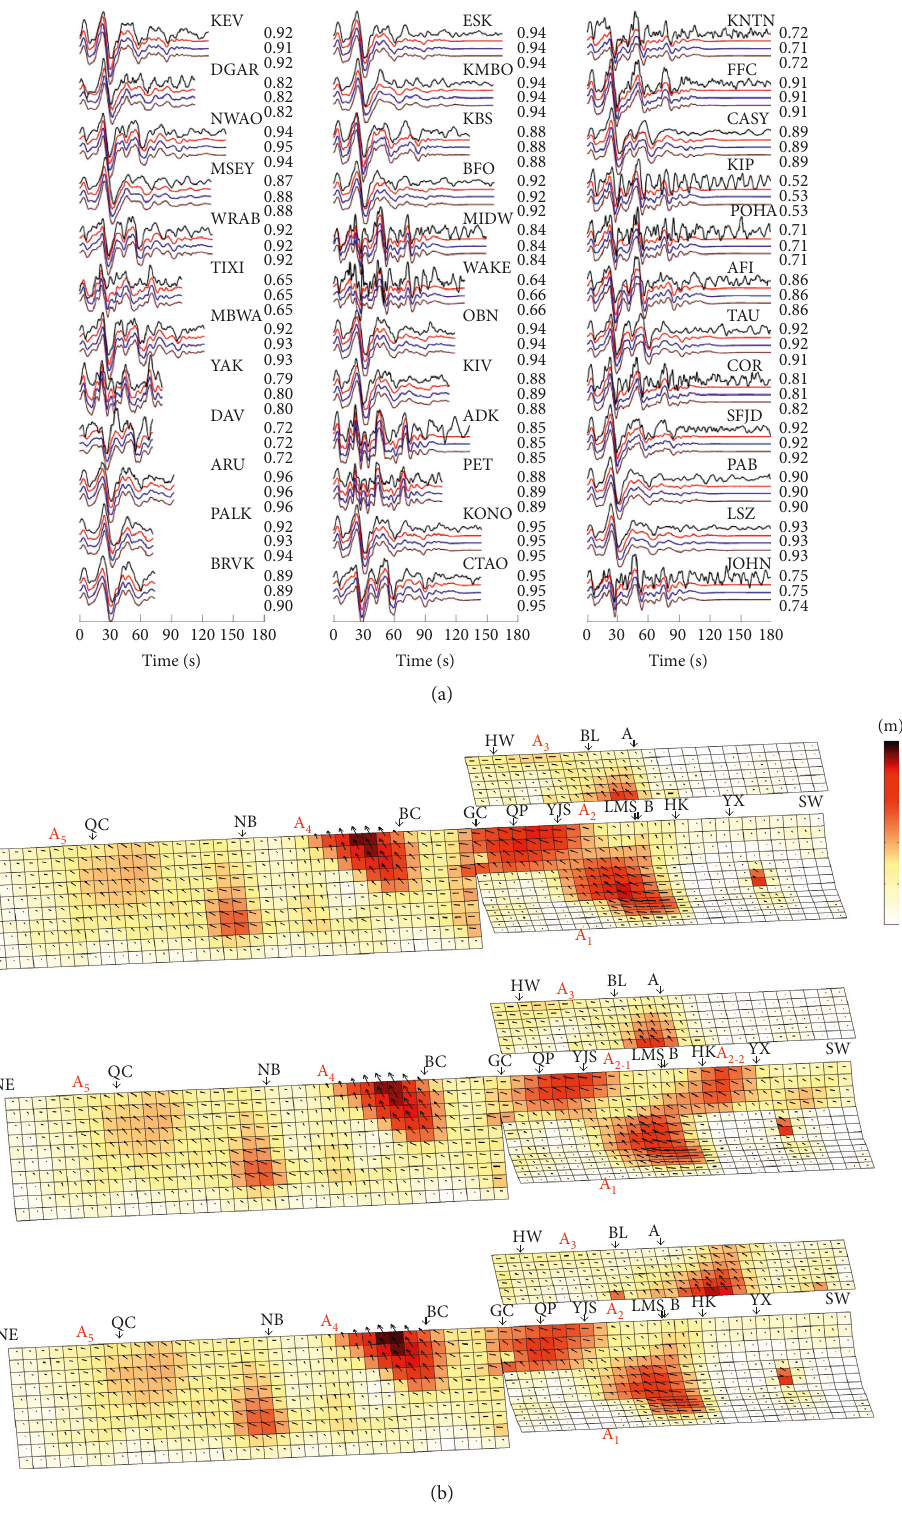
Figure 8: Comparison between observed teleseismic records (black) and synthetic records of sequence 1 (red), 2 (blue), and 3 (brown). The slip distribution of rupture velocity 3.0km/s of rupture sequences 1, 2, and 3. Point A and B are the surface intersection between the XYDF and PGF as well as the southern